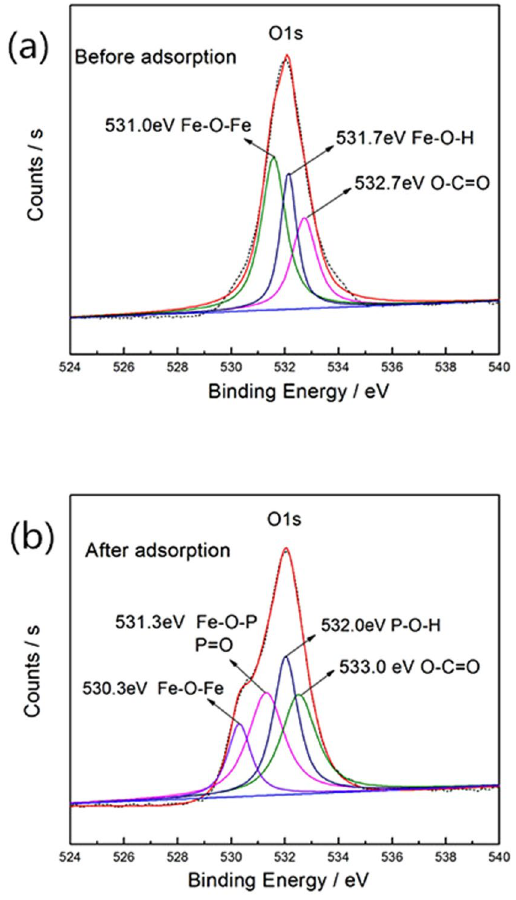
Figure 17. O1s XPS spectra of the MIL-101(Fe) ( a ) before and ( b ) after phosphate